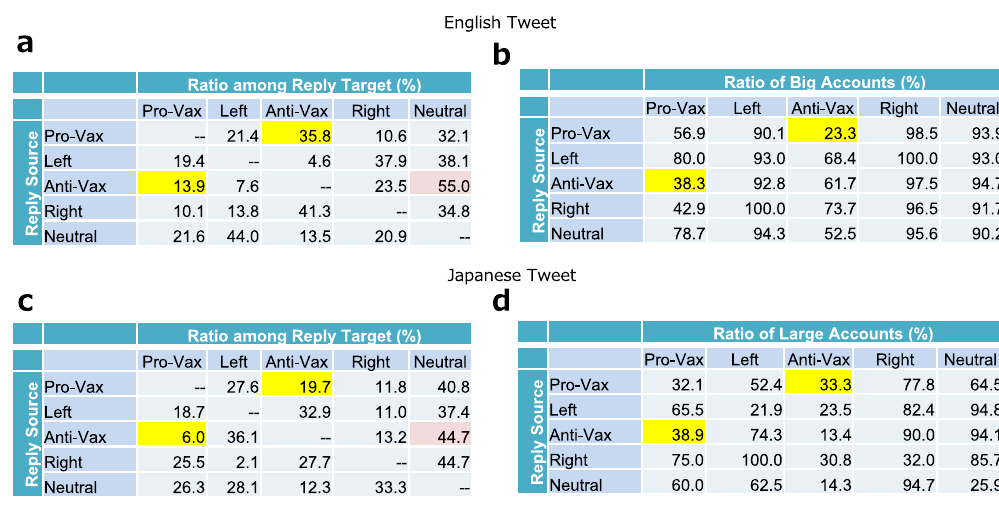
Fig. 3 Ratio of targeted clusters and popular accounts in inter-cluster replies. a Ratio of inter-cluster replies by source and target pairs in English; b Ratio of popular accounts (with the number of followers ≥ 10,000) in each targeted cluster. c and d are Japanese counterparts of a and b ,